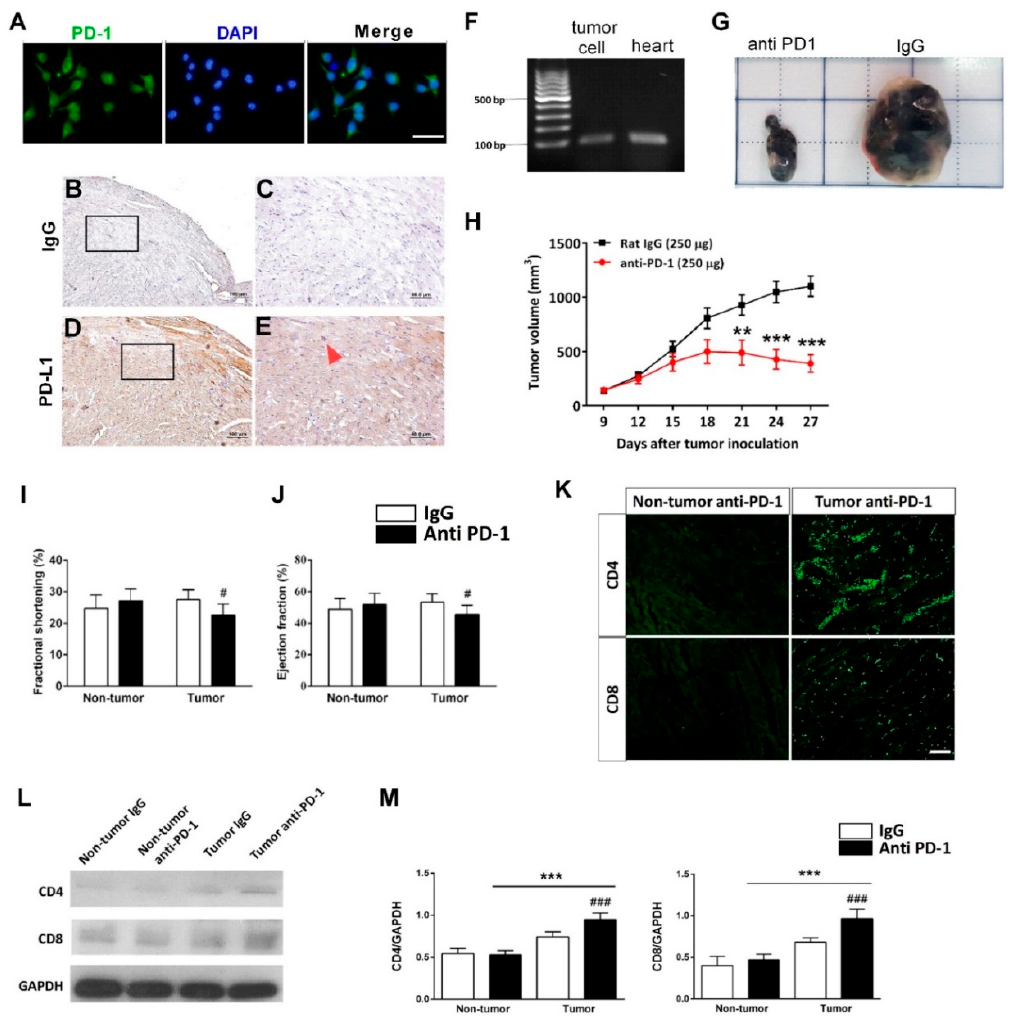
Figure 4. E ff ects of anti-PD-1 immunotherapy on tumor growth in tumor-bearing mice. ( A ) Representative micrographs showing immunostained PD-L1 + cells (green) on the B16-F10 cells. Scale bar: 50 µ m. Representative immunohistochemistry staining for IgG ( B , C ) and PD-L1 ( D , E ) on mouse heart. The inset box, showing the enlarged pictures for the indicated square area. Scale bars in (B) and (D), 100 µ m; scale bars in (C) and (E), 50 µ m. Red arrow: PD-L1 + cell. ( F ) Representative PCR analysis of PD-L1 in B16-F10 cells and mouse heart. PD-L1, programmed death-ligand 1. ( G ) Representative photograph of xenograft tumors at the end of the experiment. ( H ) Tumor growth curves for each experiment group. ** p < 0.01, *** p < 0.001 versus rat IgG group ( n = 7), two-way ANOVA, posthoc Bonferroni test. E ff ects of anti-PD-1 immunotherapy on mouse heart function. The quantitative data of fractional shortening ( I ), and ejection fraction ( J ) of rat IgG and anti-PD-1-treated group. # p < 0.05 versus rat IgG-treated tumor group ( n = 7); # p < 0.05 versus anti-PD-1-treated non-tumor group ( n = 7). ( K ) Representative micrographs showing immunostained CD4 + and CD8 + cells (green) in the myocardium. Scale bar: 1000 µ m. ( L ) Representative western blot analysis and quantitative results ( M ). *** p < 0.001 versus anti-PD-1-treated non-tumor group; ### p < 0.001 versus rat IgG-treated tumor group ( n = 4), two-way ANOVA, posthoc Bonferroni test. Data are shown as the mean ± SD.